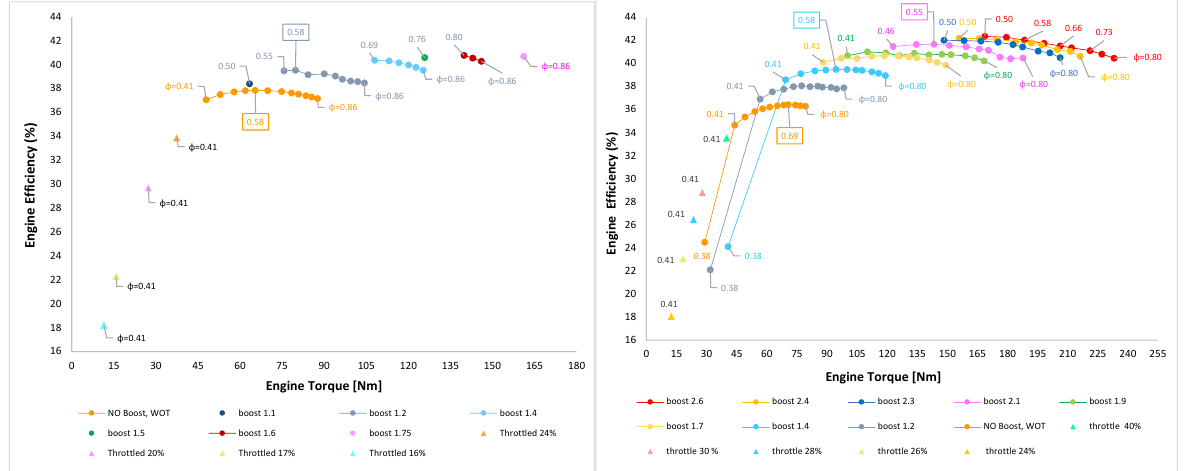
Figure 5. Engine efficiency as a function of the engine torque for different boost pressures [bar] and equivalence ratios. In some operating points, the equivalence ratio value is reported. For some boost levels, the equivalence ratio value maximizing the efficiency is also highlighted.